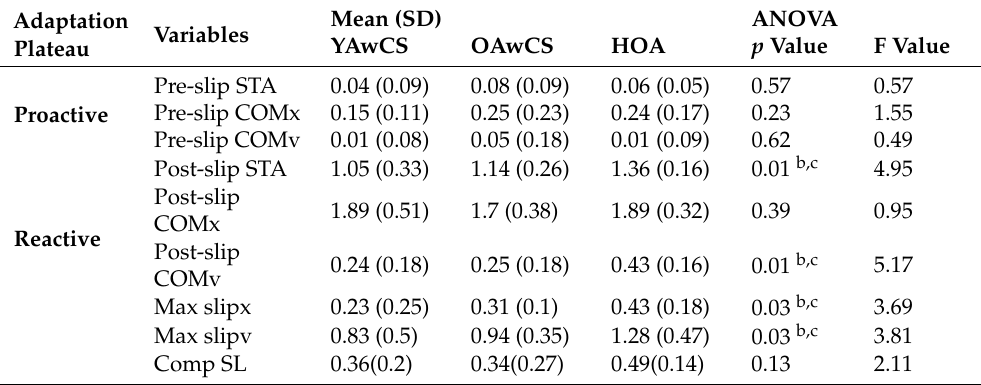
Table 3. Means and standard deviations of adaptation plateau for all the kinematic variables. One- way ANOVA was conducted to examine the group effect on the adaptation